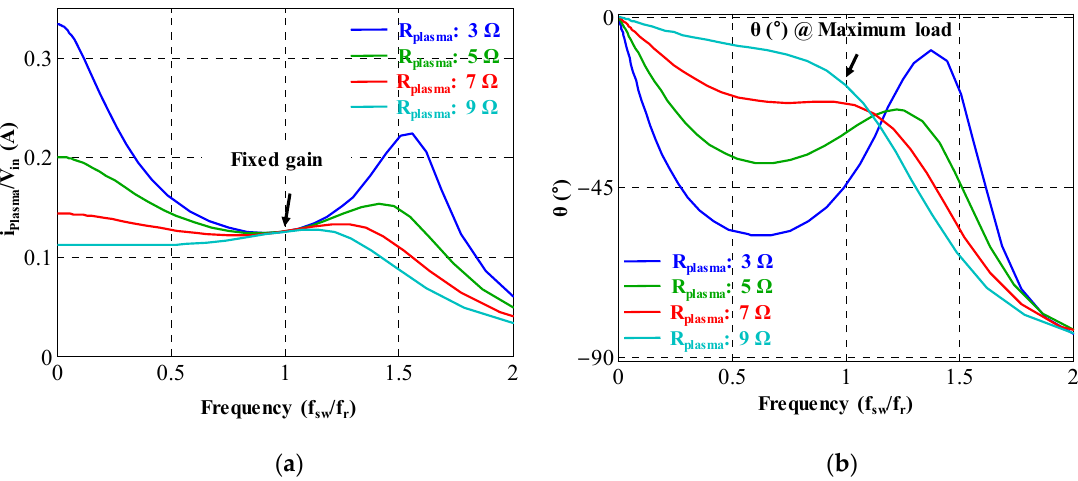
Figure 5. Characteristics of LCL network for designing a power conditioning system (PCS): ( a ) output current characteristics of the LCL network and ( b ) phase angle characteristics of the LCL network.